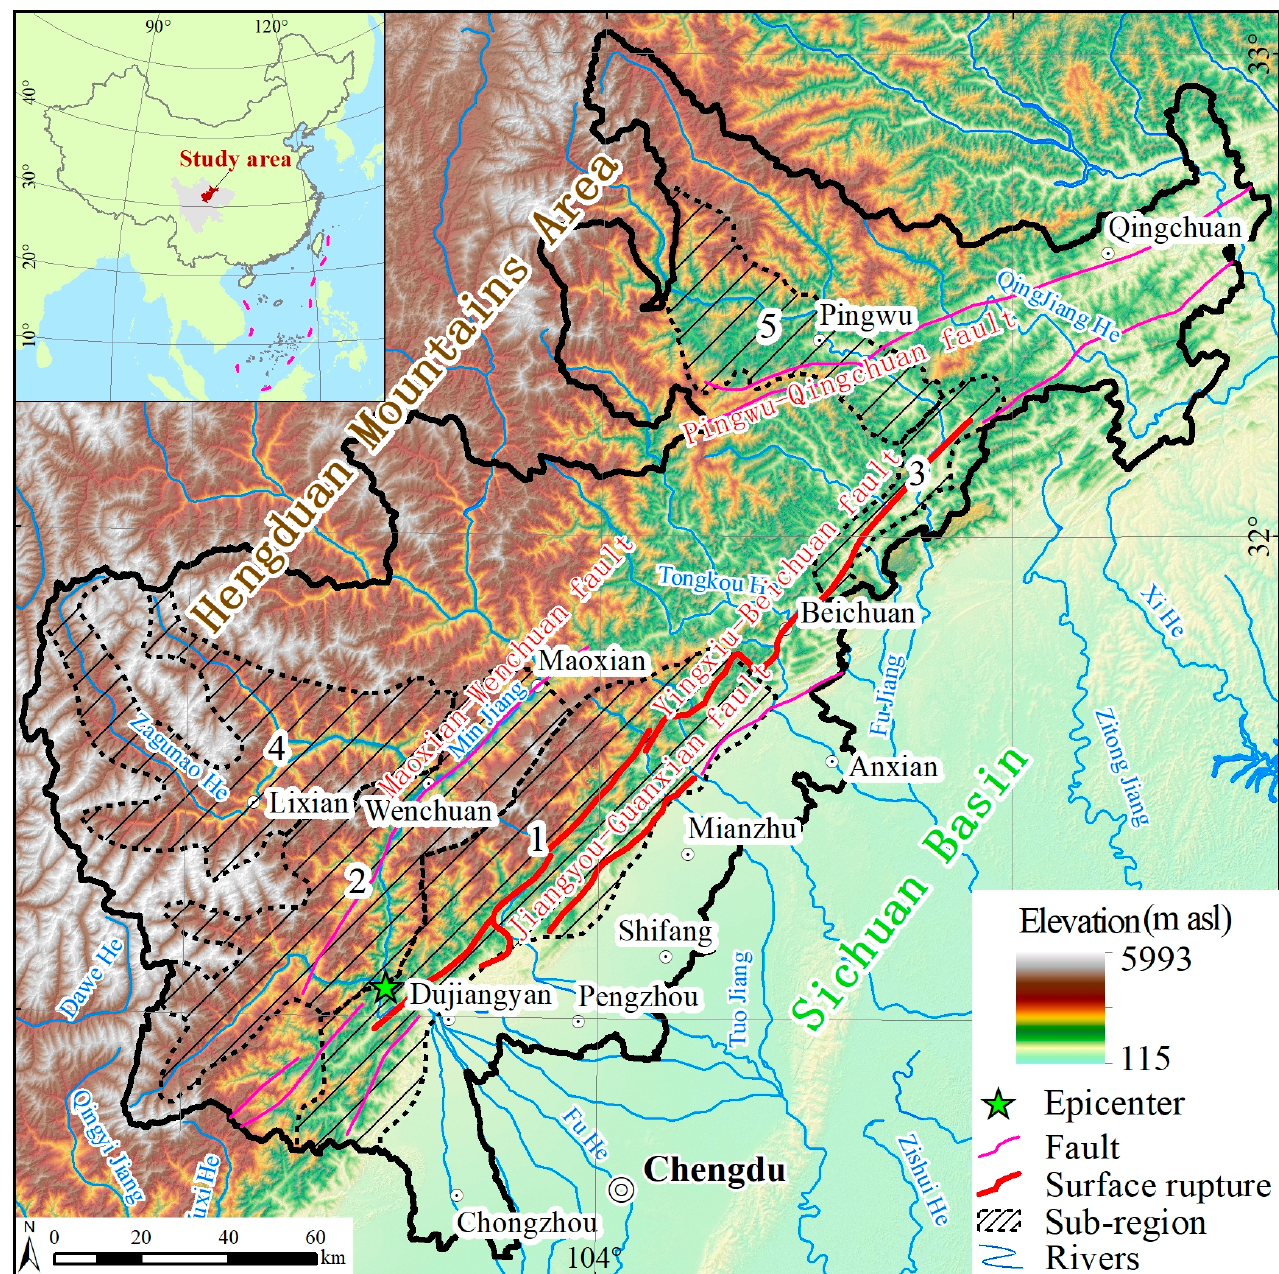
Figure 1. General view of the study area. Rectangular frames with slashes show the typical area of debris flow activity, numbered 1–5.